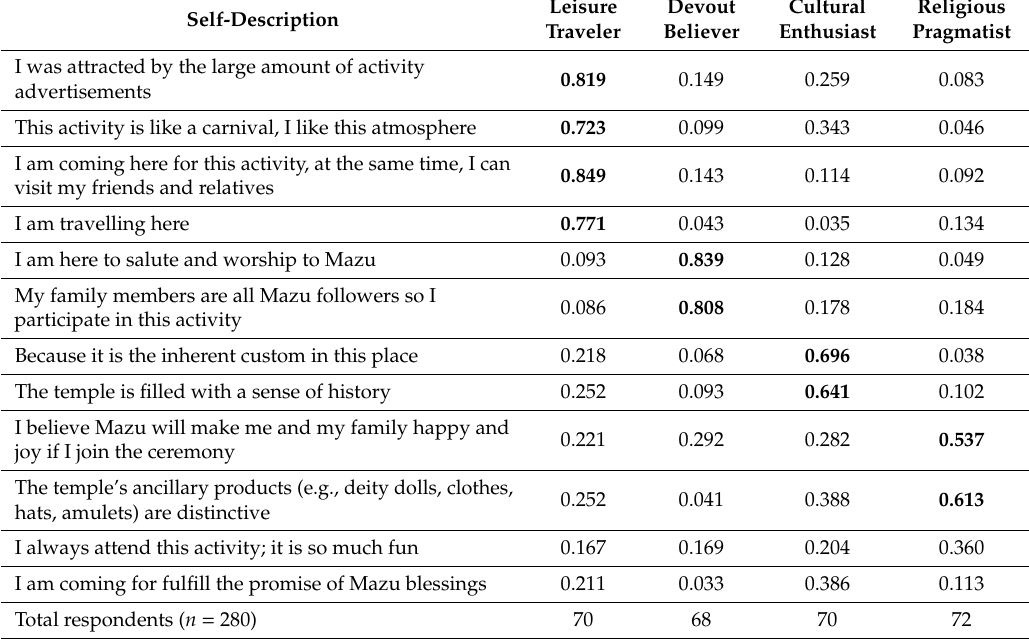
Table 2. The motivations of religious activity participant—factor analysis